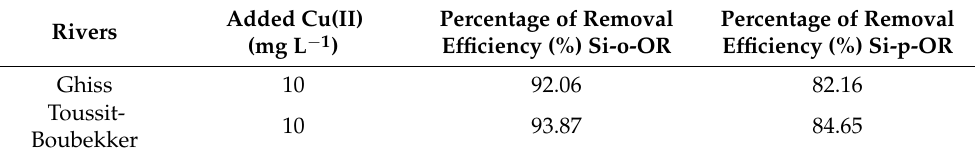
Table 6. Removal of copper from real wastewater samples using Si-o-OR and Si-p-OR .